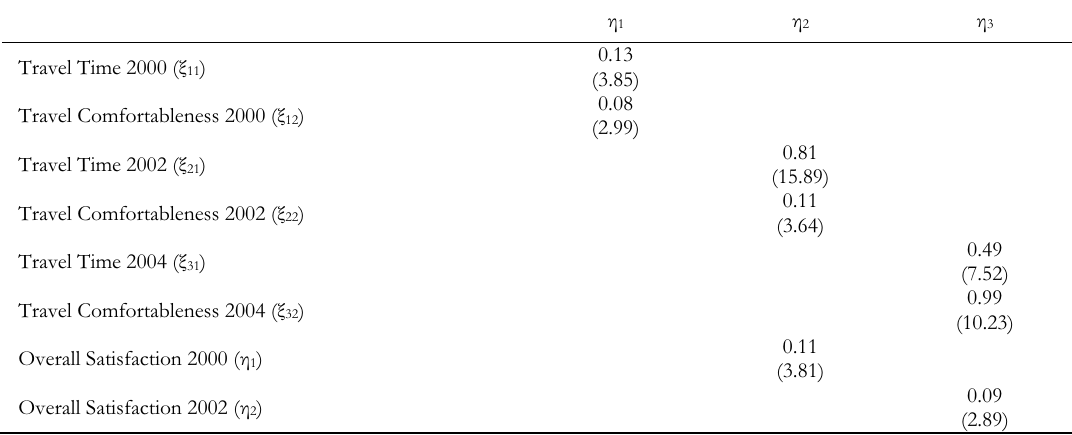
Structural model coefficients estimates (t values in